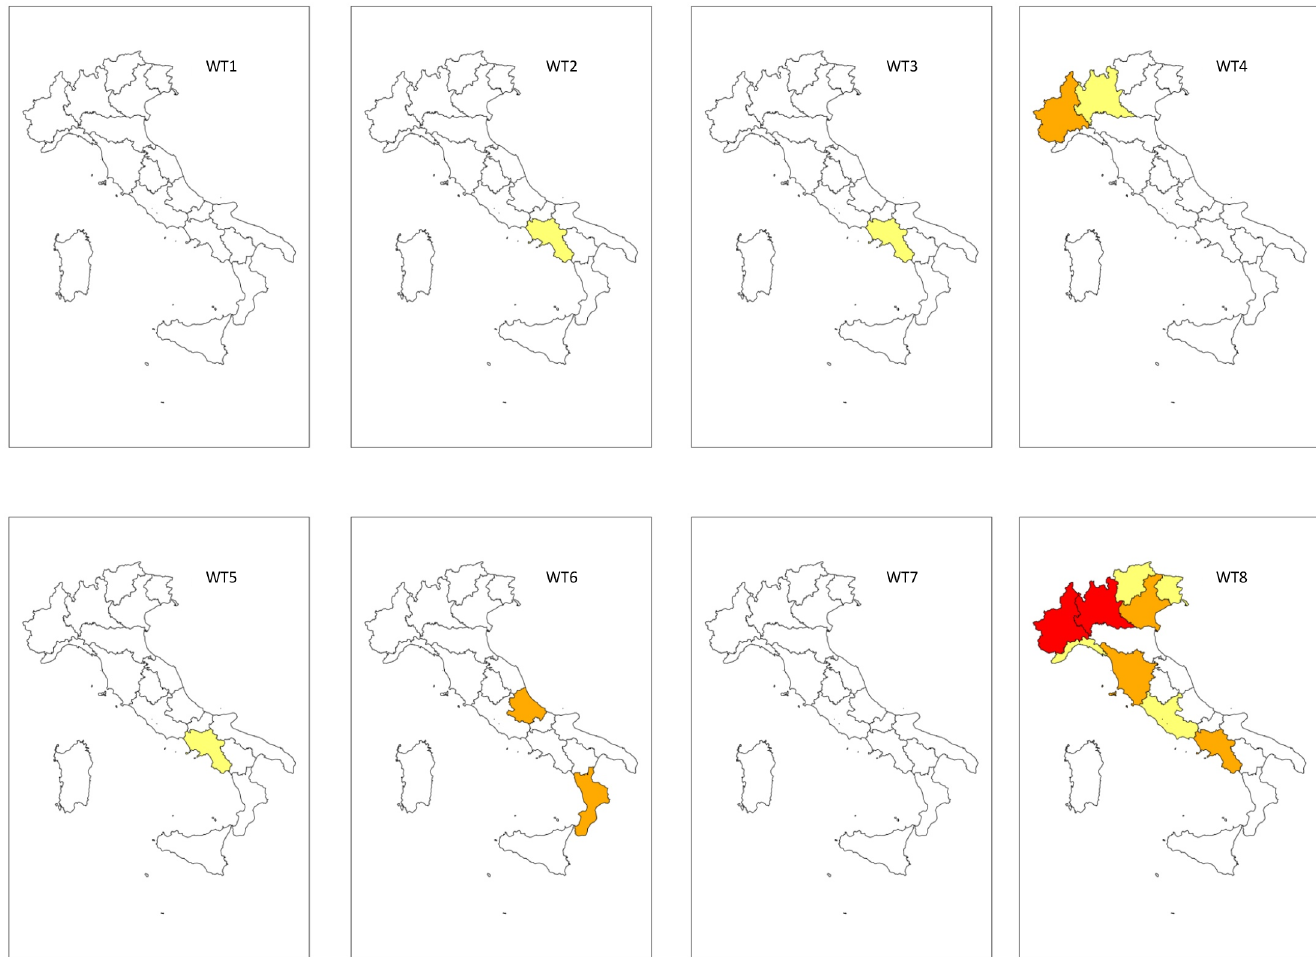
Fig 4. Mapping of the annual WT-related Floods and LAndslides Risk Index (WT-FLARI). WT (Weather Type). WT-FLARI levels: red = Very High (WT-FLARI > 99 th perc.); orange = High (95 th perc. > WT-FLARI > 99 th perc.); yellow = Moderate (95 th perc. > WT-FLARI > 90 th perc.); white = Low (WT-FLARI < 90 th